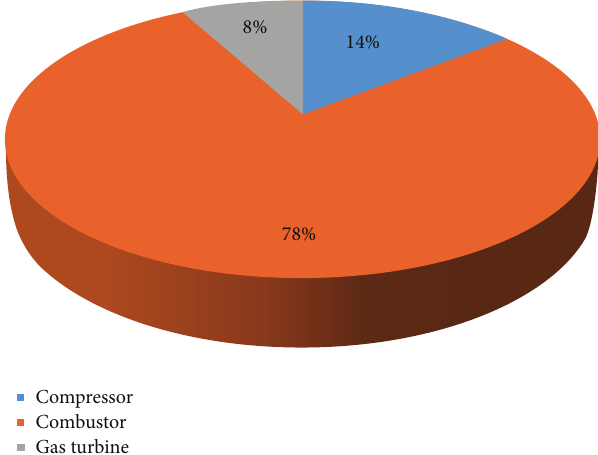
Figure 7: Nonrenewable exergy destruction distribution in GT- solar cycle (kW).